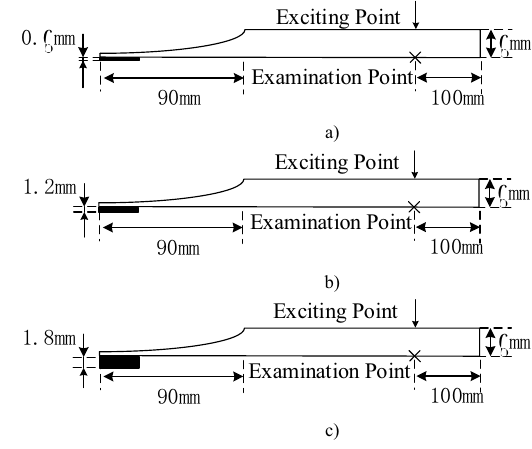
Figure 7: Calculation conditions of acoustic black holes with dif - ferent damping layer thicknesses. ( a ) Condition 1 μ = 10%, ( b ) condition 2 μ = 20%, and ( c ) condition 3 μ = 30%.